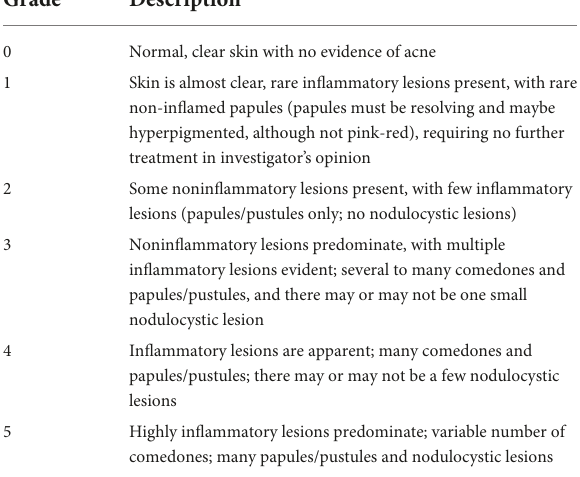
TABLE 2 Global acne assessment